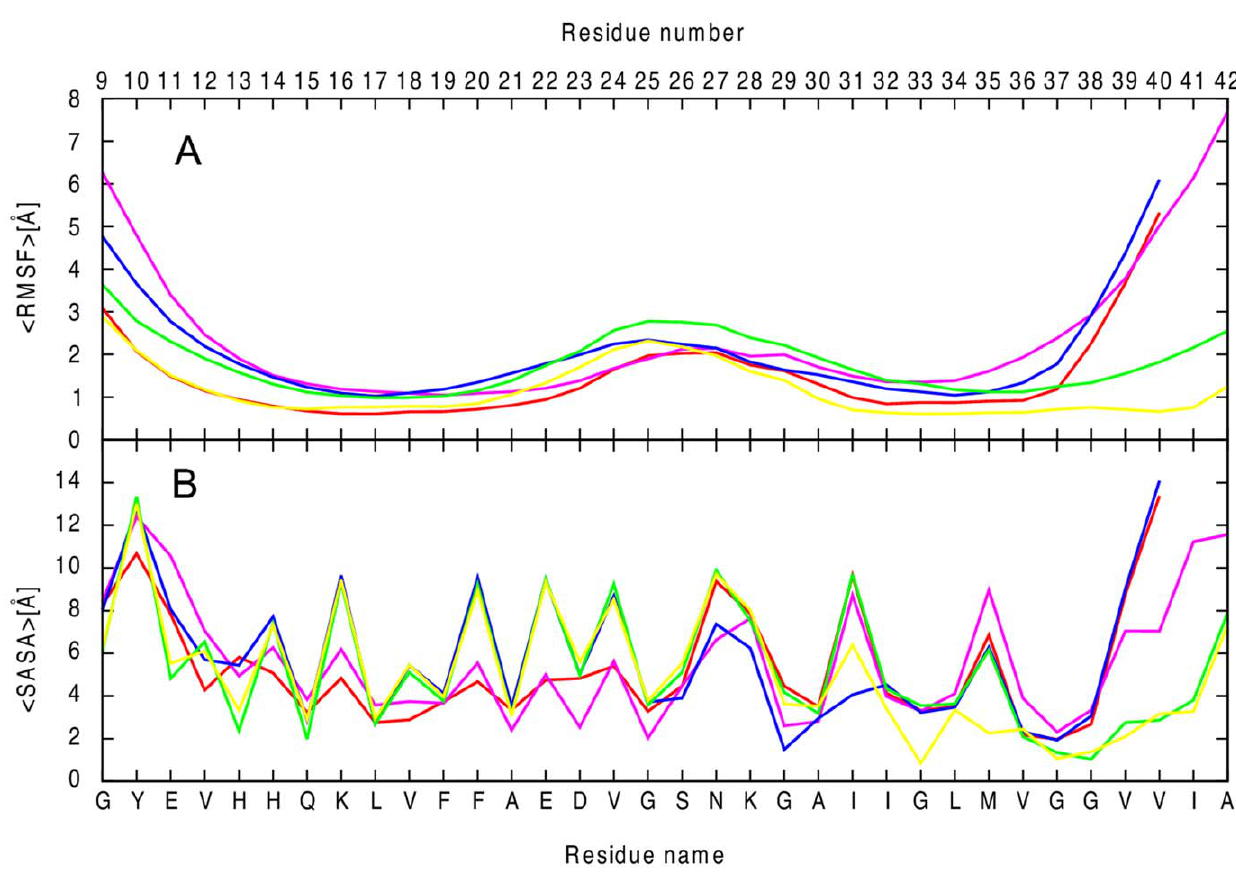
Figure 3. Comparison of all-atom root-mean-square deviation and solvent accessible surface areas of A b segmental polymorphism models. Backbone C a atom-positional root-mean-square fluctuations, RMSF, along the amino acid sequence for the five models (A). The results are the average of two independent salutation of each system. The variation of average per residue solvent accessible surface area for each models (B). Red, 16–21P; pink, 16–21AP; blue, 27–32; green, 35–42; yellow, 30–42.